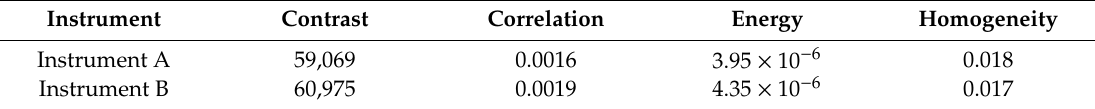
Table 5. Statistical values for contrast, correlation, energy and homogeneity for comparison of the XCT data acquired by two XCT instruments (A and B), given for the magnetite-bearing quartzite. Average values are given for the GLCM statistics extracted for the entire 3D volume (~1000 images per